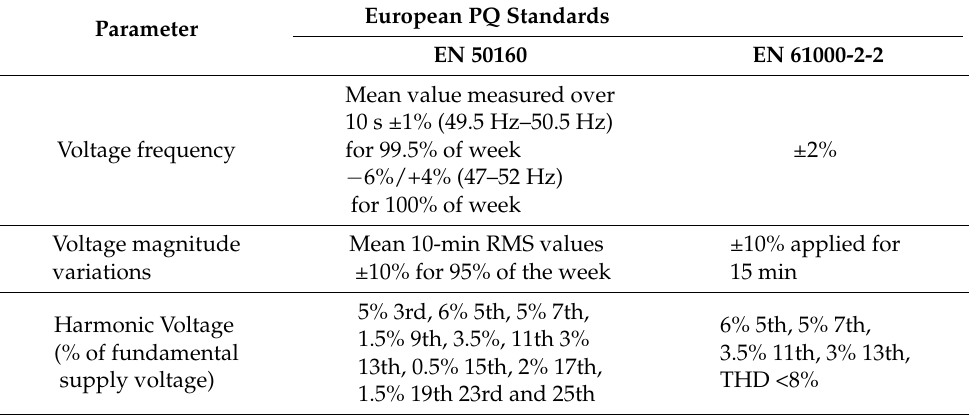
Table 2. Limits of European Standards for PQPs